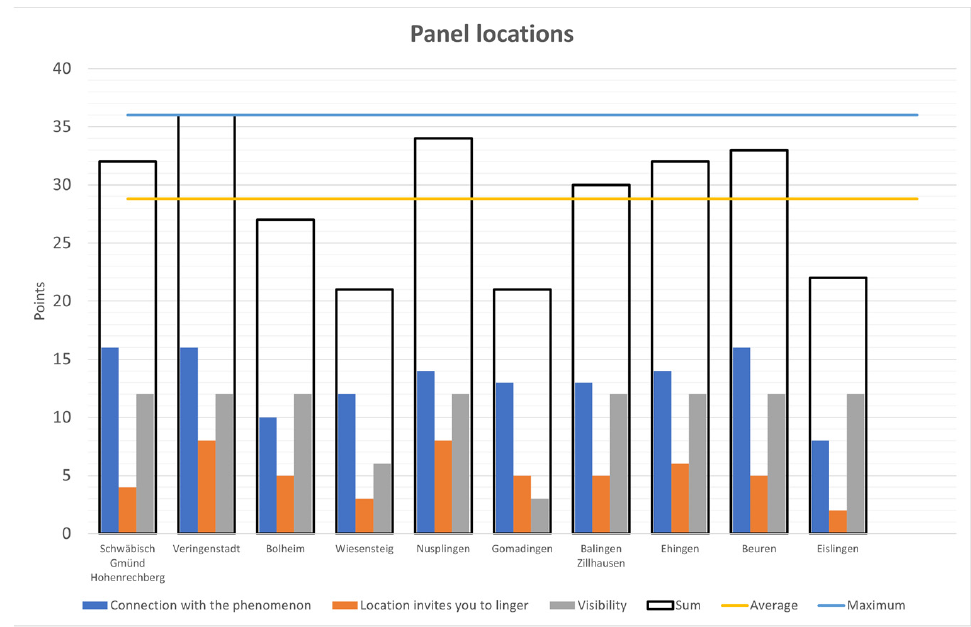
Figure 23. Panel locations (Julian Stolz